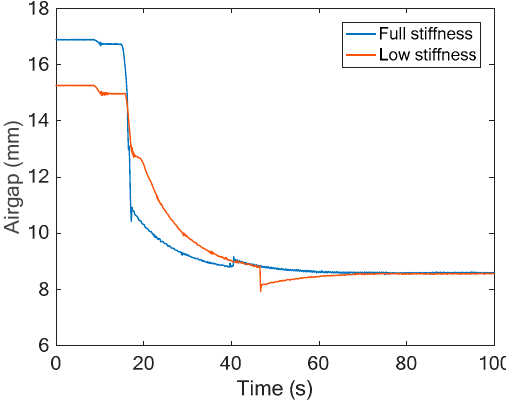
Figure 15. Effect of bridge stiffness on the airgap.